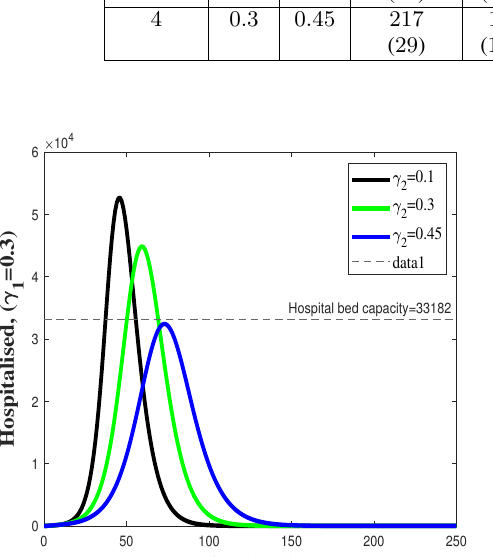
asymptomatic infectives.